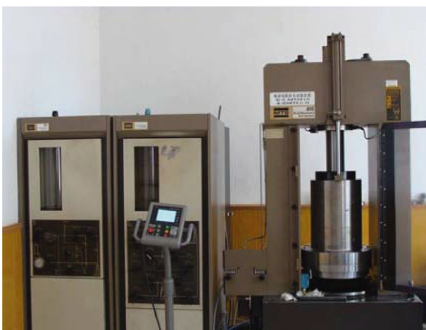
Figure 2: MTS815.02 electrohydraulic servo rock mechanics test